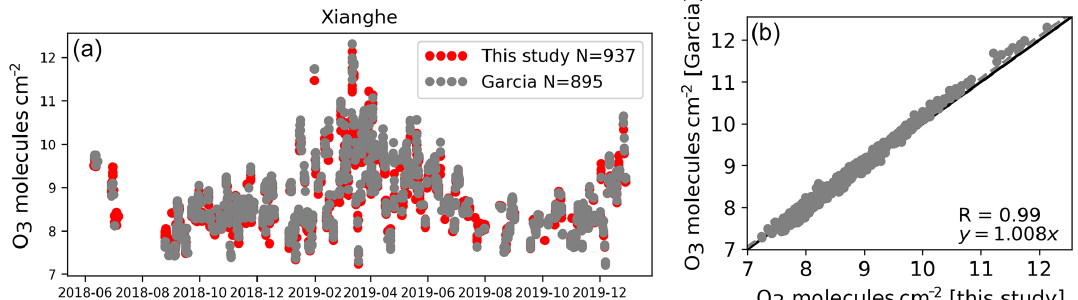
Figure A2. The time series the FTIR-retrieved O 3 total column using the windows in this study and by García et al. (2014) at Xianghe (a) , together with their correlation (b)